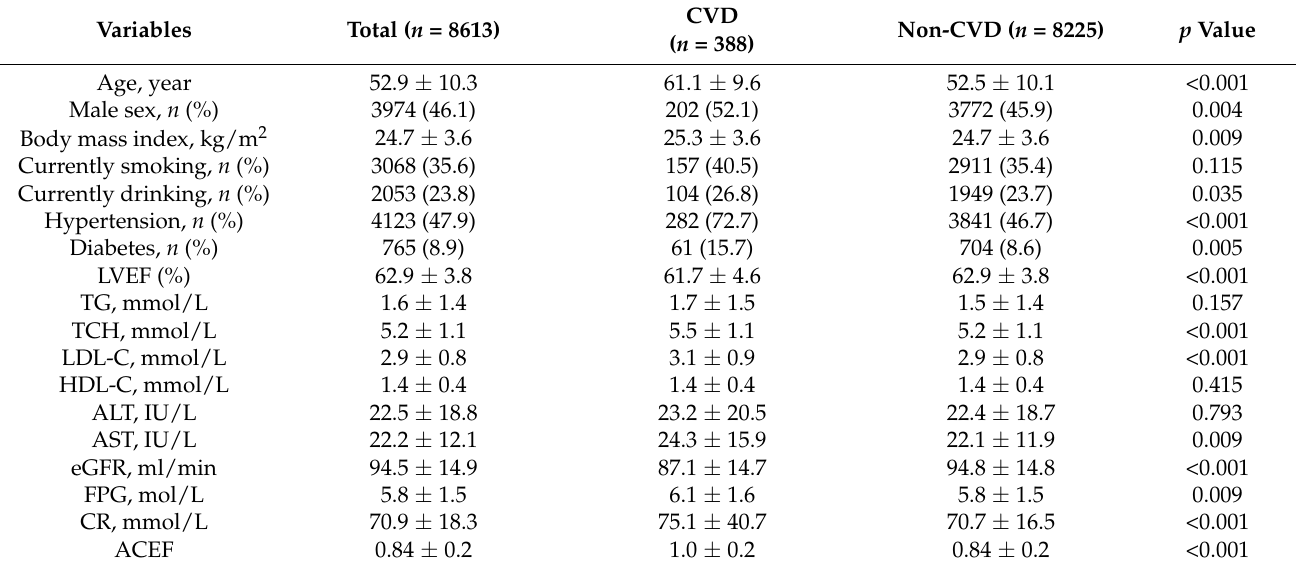
Table 1. Baseline characteristics of study